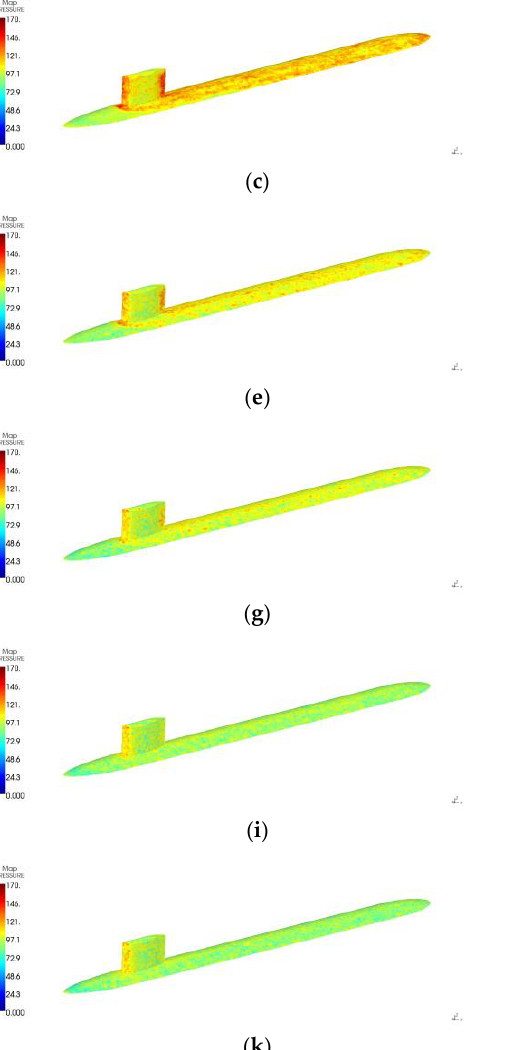
Figure 14. The fluctuation pressure contour of the two models at different frequencies. ( a ) The original model at 50 Hz; ( b ) The model with leading-edge serrations at 50 Hz; ( c ) The original model at 200 Hz; ( d ) The model with leading-edge serrations at 200 Hz; ( e ) The original model at 400 Hz; ( f ) The model with leading-edge serrations at 400 Hz; ( g ) The original model at 600 Hz; ( h ) The model with leading-edge serrations at 600 Hz; ( i ) The original model at 1200 Hz; ( j ) The model with leading-edge serrations at 1200 Hz; ( k ) The original model at 1600 Hz; ( l ) The model with leading-edge serrations at 1600 Hz.